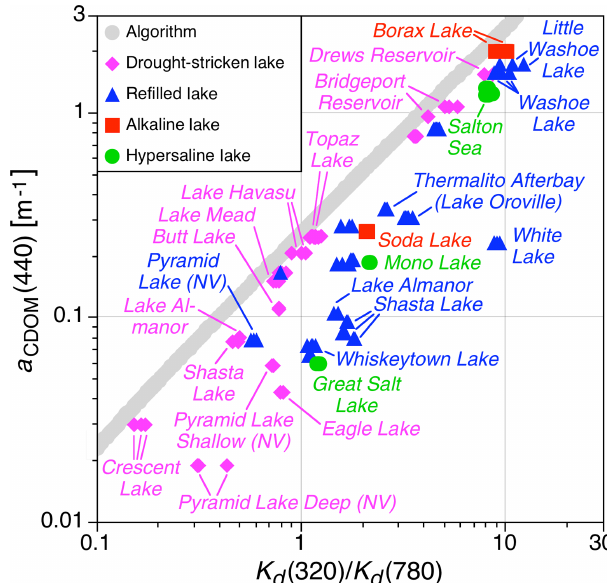
Figure 4. The new data from lacustrine water bodies that were drought-stricken (magenta diamonds), refilled after drought (blue triangles), alkaline (red squares), or hypersaline (green circles) in relation to the original algorithm (gray circles). Each data point rep- resents a single water sample with multiple optical casts for each, which results in a series of results (typically three to six) along the x